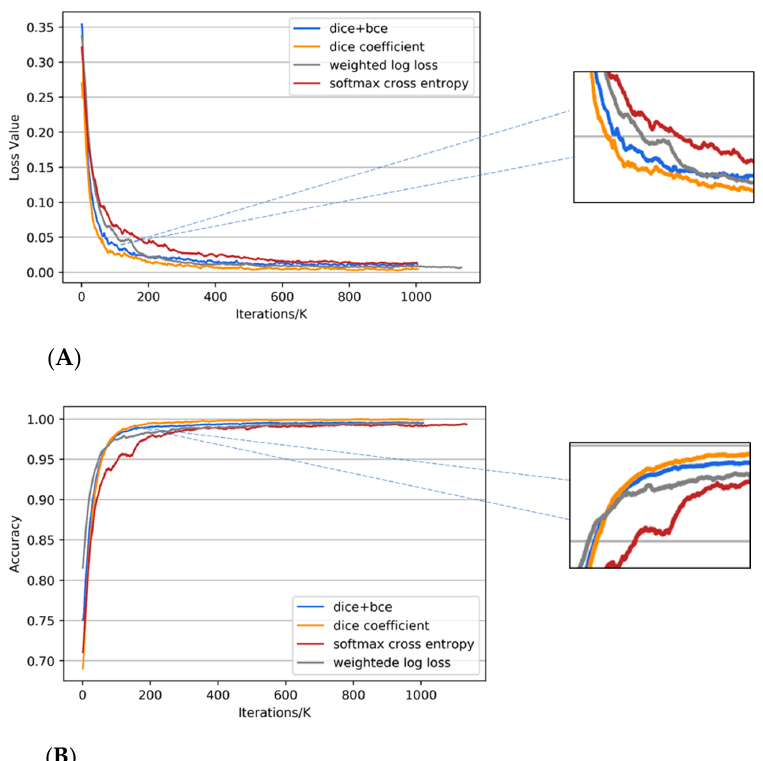
Figure 9. Progression of loss values ( A ) and training accuracy ( B ) for four loss functions used with Nested SE-Deeplab during training. The loss functions are softmax cross entropy (softmax), weighted log loss, dice coefficient (dice), and dice coefficient added with binary cross entropy